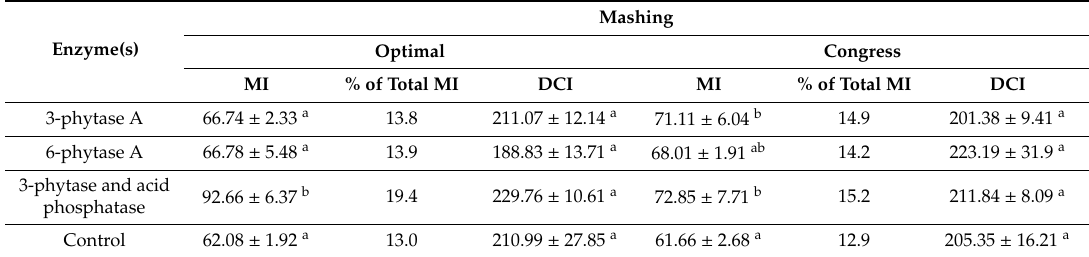
Table 1. Bioactive inositols contents ( µ g / mL) in buckwheat